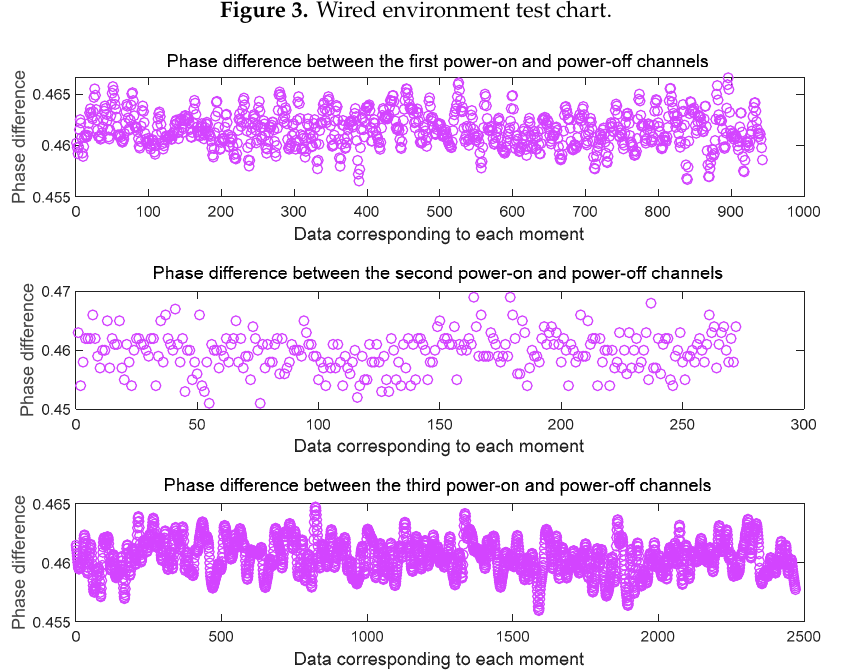
Figure 5. Test of influence of power on/off on B1 phase difference results between channels.